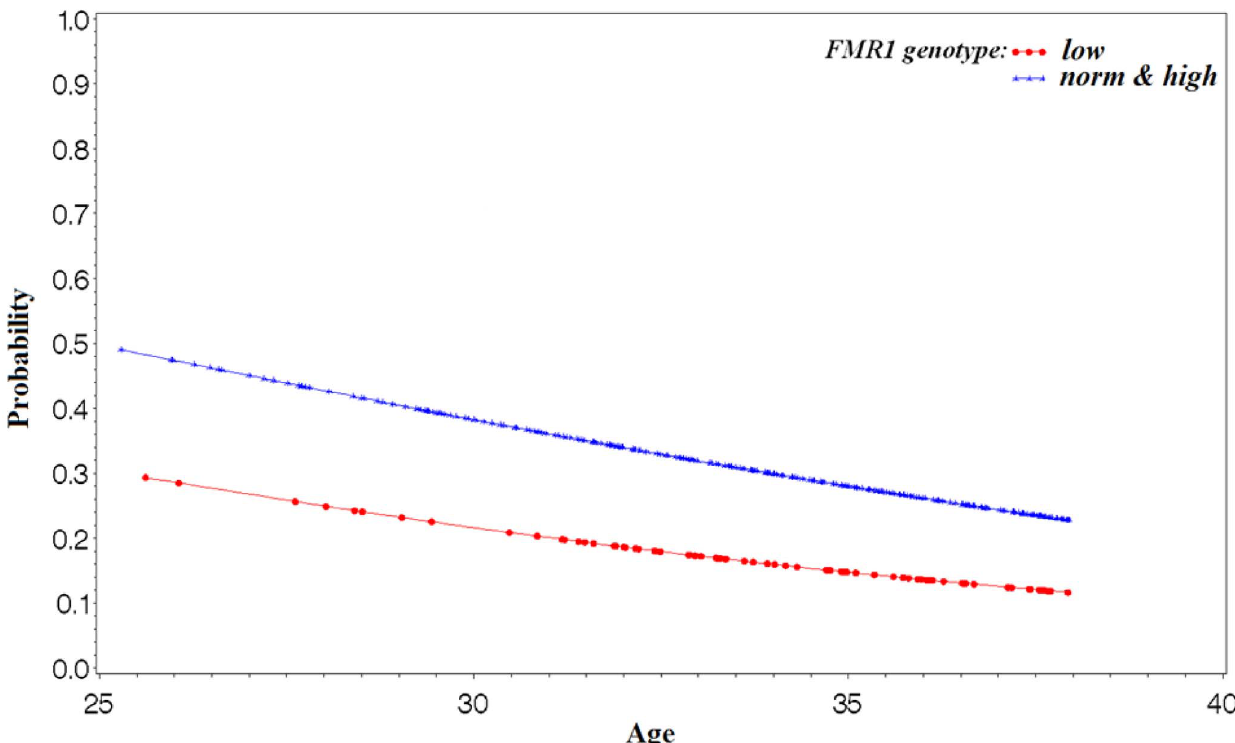
Figure 4. Predicted probabilities of clinical IVF pregnancy in infertile patients based on age and FMR1 .